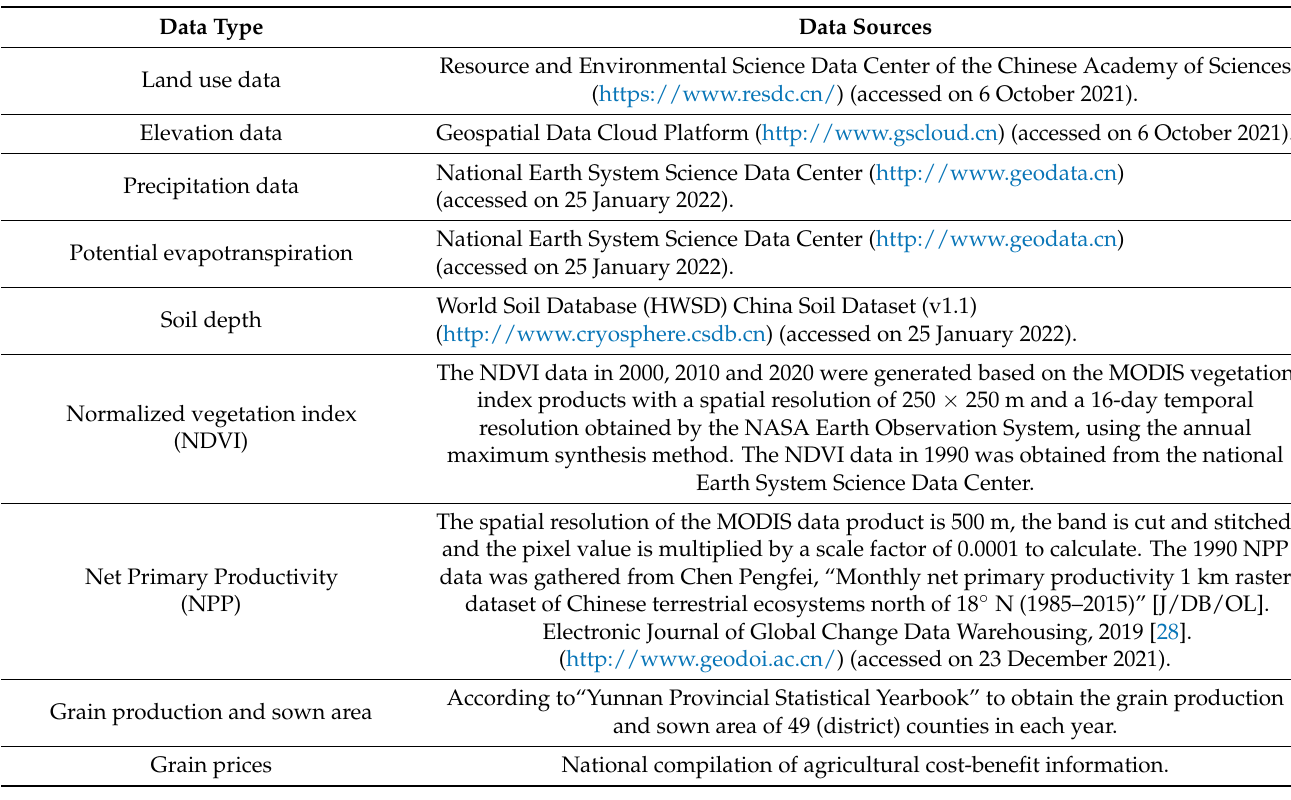
Figure 2. Flowchart of methodological steps. ESI (ecosystem service index), PH (physical health index), EHI (ecosystem health index). Table 1. Study data